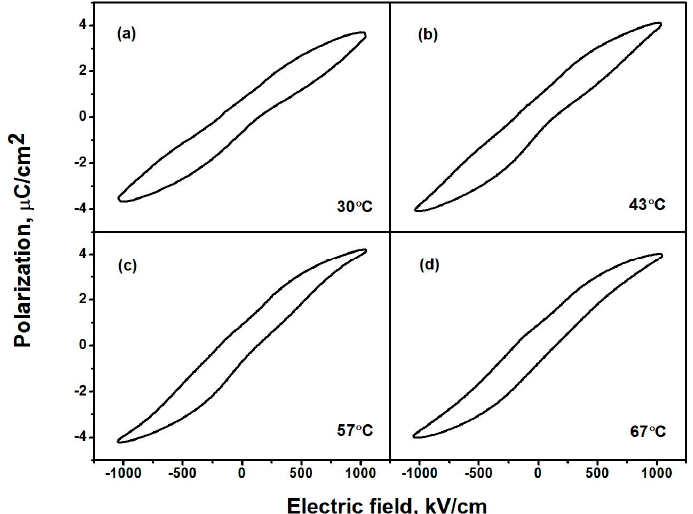
Figure 2. Hysteresis loops of P(VDF–TrFE)–BTNW nanocomposites with 5% volume fraction of BT nanowires at different temperatures.